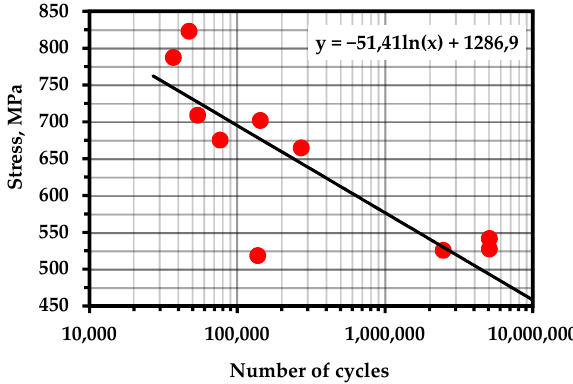
Figure A2. S–N Curve—Steel D2 (Temperature—293 K; frequency—23 Hz; R = 0.75) [99].